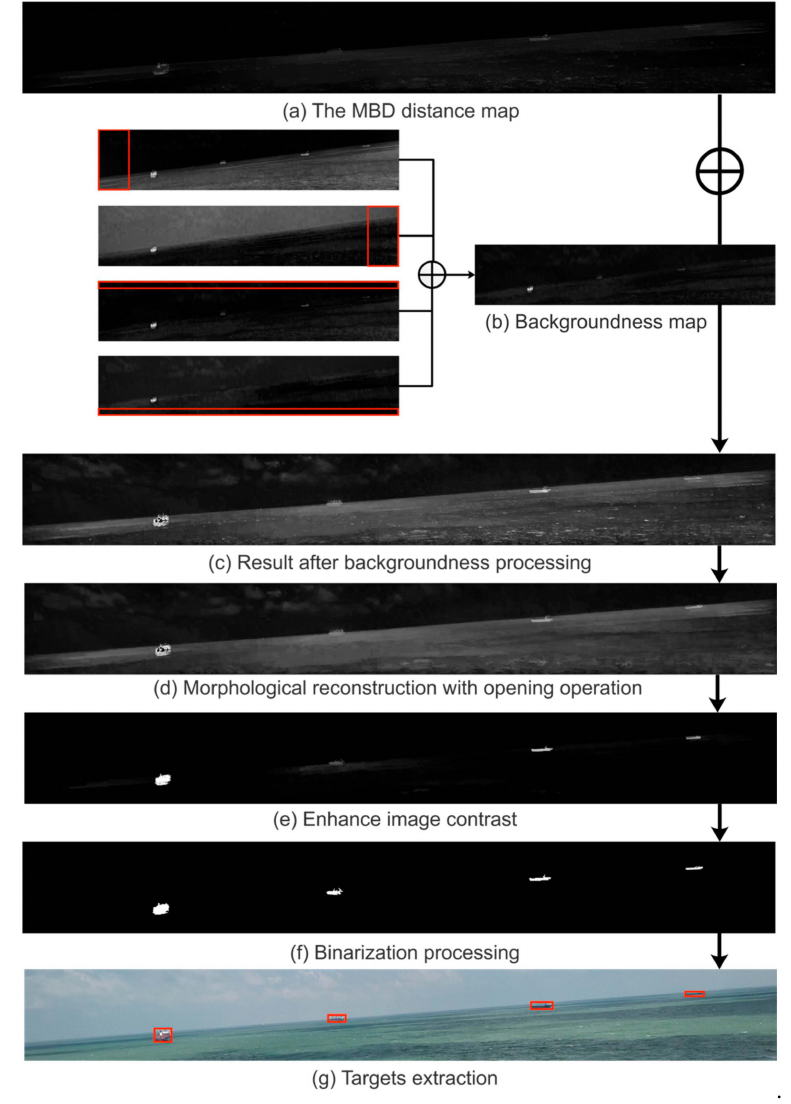
Figure 9. A processing case for targets detection. ( a ) is obtained by fusing the average values of the MBD maps of the three channels L, a, and b. In ( b ), each red box represents 10% of the image area in the four directions of up, down, left, and right, and ⊕ represents the average of the four images after adding. ( d , e ) represent post-processing, where n = 8 and a = 10. ( f , g ) represent foreground segmentation, where the binarization threshold is 5 times the average intensity of ( e ), and the area threshold is 100